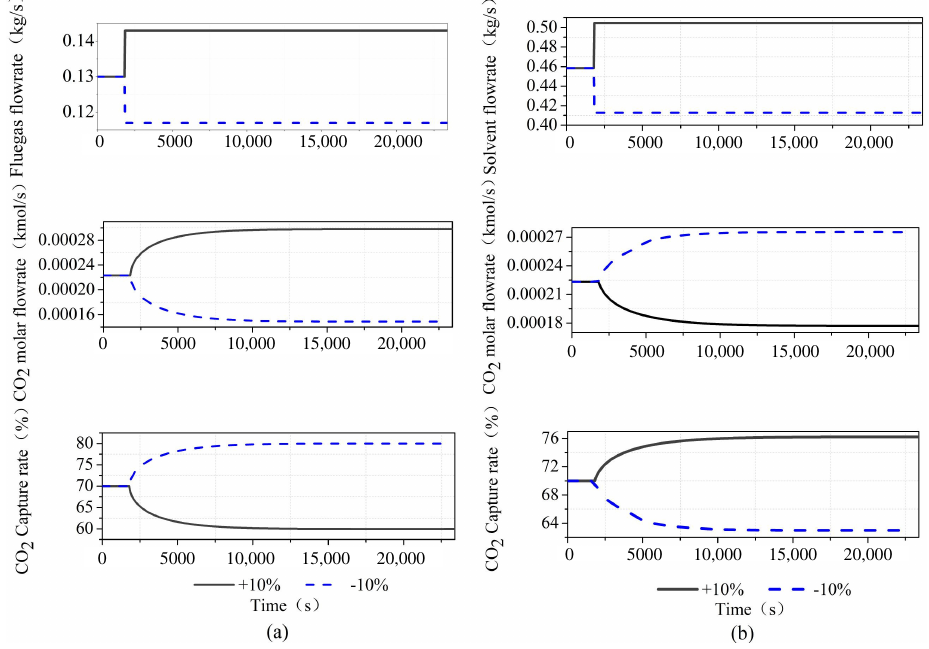
Figure 5. Dynamic test of CO 2 capture system in Aspen Plus Dynamics: ( a ) ± 10% step of flue gas flowrate; and ( b ) ± 10% step of lean solvent